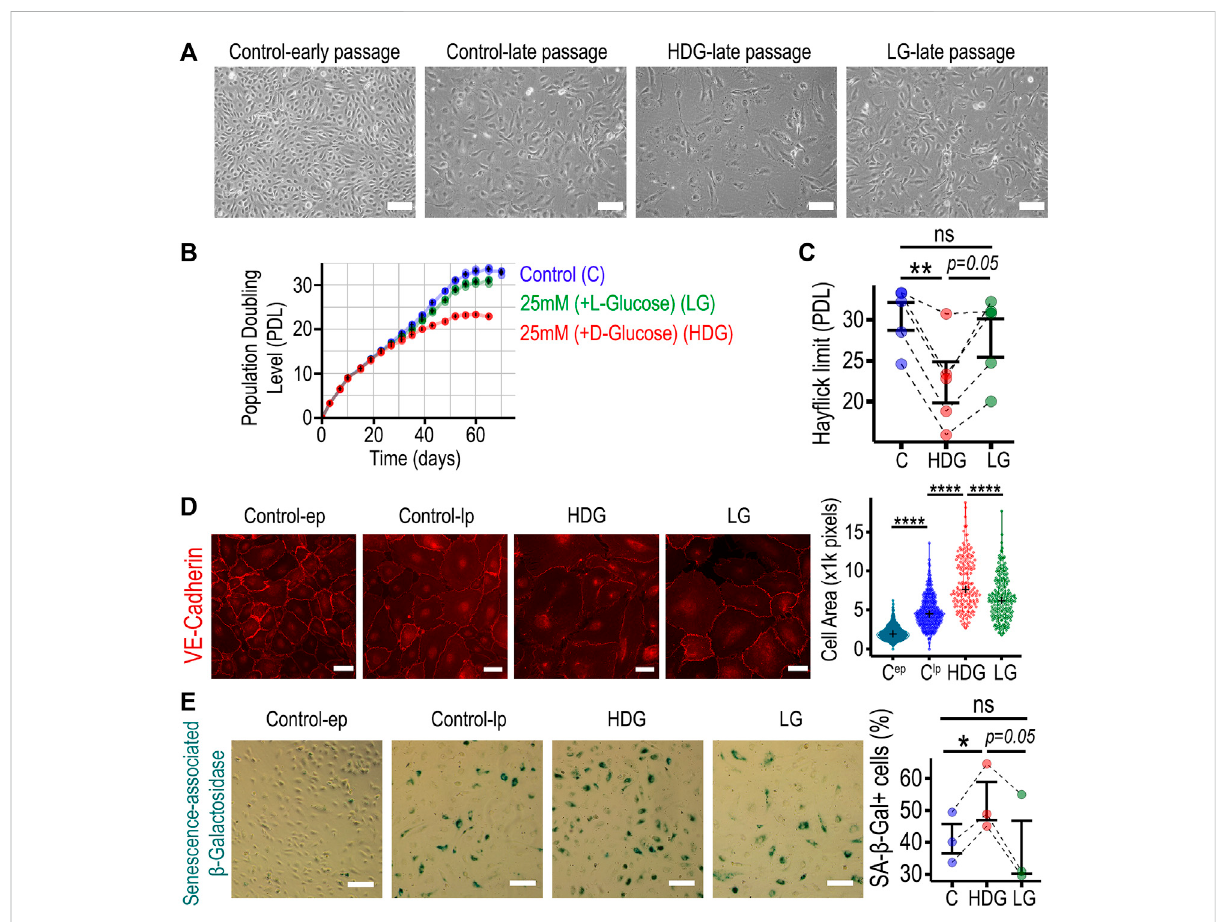
FIGURE 1 HRMECsundergoprematurecellularsenescencewhenculturedlongtermwith25 mMD-Glucose. (A) Phase-contrast10Xmicroscopyimages of HRMECs at early passage (P4-P5), late passage (P11-P16), and experimental groups of late passage HRMECs treated with high glucose conditions (HDG or LG). Scale bar: 150 µm. (B) Growth curves for three experimental groups: control group cultured under 5 mM D-glucose, osmotic control topped up to 25 mM with L -glucose, and high glucose with 25 mM D-glucose. HRMECs were counted after every passage with automated CASY cell counter, cumulative population doublings calculated and plotted against time in culture. (C) For maximal cell number expansion, population doubling level reached at the Hay fl ick limit was used for statistical comparison. (D) Representative 20X images of VE-cadherin immunostaining in HRMECs after 4 weeks in culture to evaluate cell surface area using ImageJ. Scale bar: 50 µm (E) Representative 10X phase- contrast images of senescence-associated β -Galactosidase staining in HRMECs after 4 weeks in culture to identify and quantify senescent endothelial cells. Scale bar: 150 µm. * p < 0.05, ** p < 0.01, **** p < 0.0001, ns: not signi fi cant. One-way ANOVA, with Tukey ’ s post-hoc analysis was used. PDL, Population doubling level; C, control (5 mM D-Glucose); LG, 25 mM (+L-glucose); HDG, 25 mM (+D-glucose); ep, early passage; lp, late